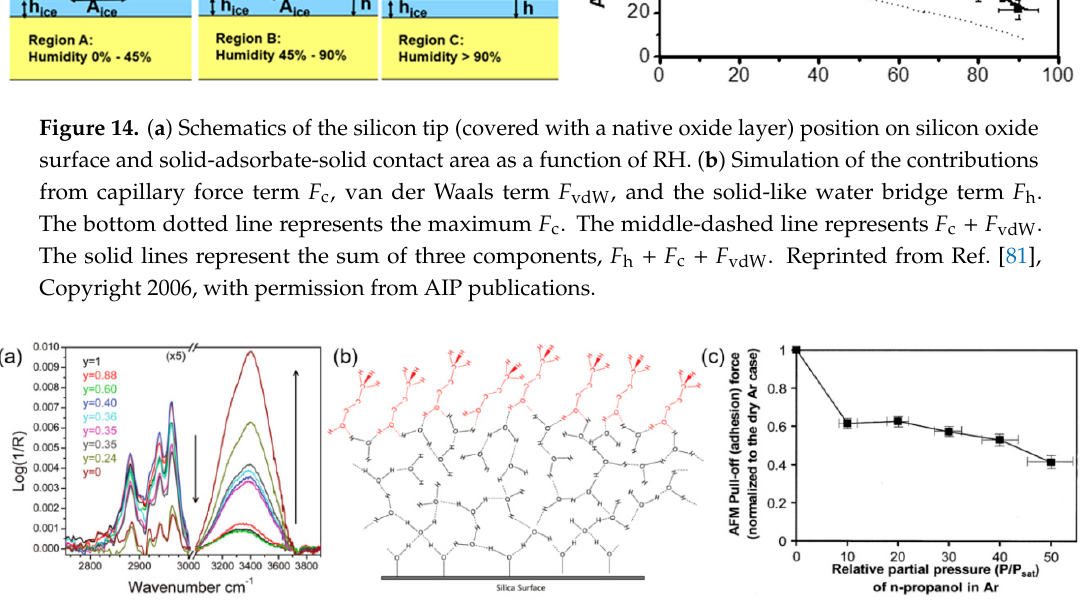
Figure 15. ( a ) ATR-IR spectra of the binary adsorbate layers of n-propanol and water on silicon oxide with the water contact angle of ~0°. ( b ) Schematic illustration of the structure for the binary adsorbate layer of n-propanol and water on silicon oxide. Reprinted from Ref. [104], Copyright 2012, with permission from ACS publications. ( c ) Adhesion force between the silicon tip (covered with a native oxide layer) and silicon oxide substrate measured with AFM as a function of n-propanol partial pressure. Reprinted from Ref. [105], Copyright 2005, with permission from Elsevier.